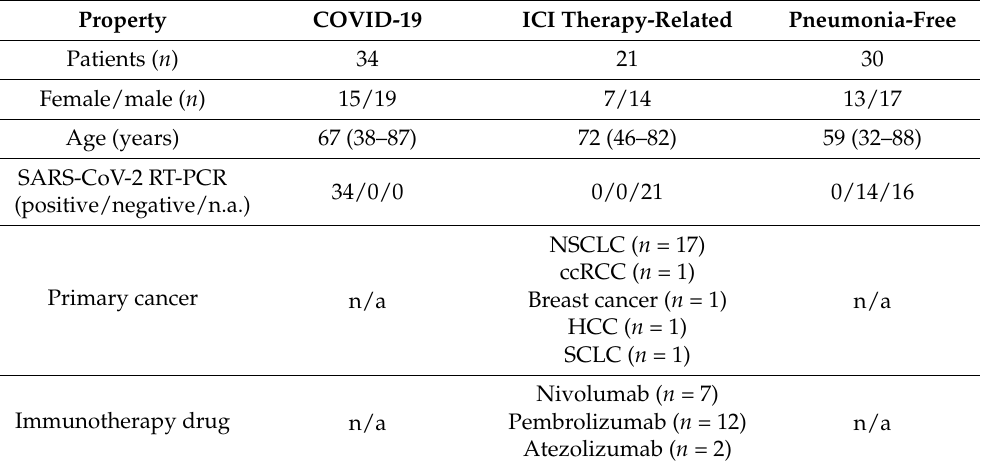
(minimum and maximum). COVID-19 = coronavirus disease 2019; ICI = immune checkpoint inhibitor; SARS-CoV-2 (severe acute respiratory syndrome coronavirus 2); RT-PCR = reverse transcriptase polymerase chain reaction. NSCLC = non–small-cell lung cancer; ccRCC = clear cell renal cell carcinoma; HCC = hepatocarcinoma; SCLC = small cell lung